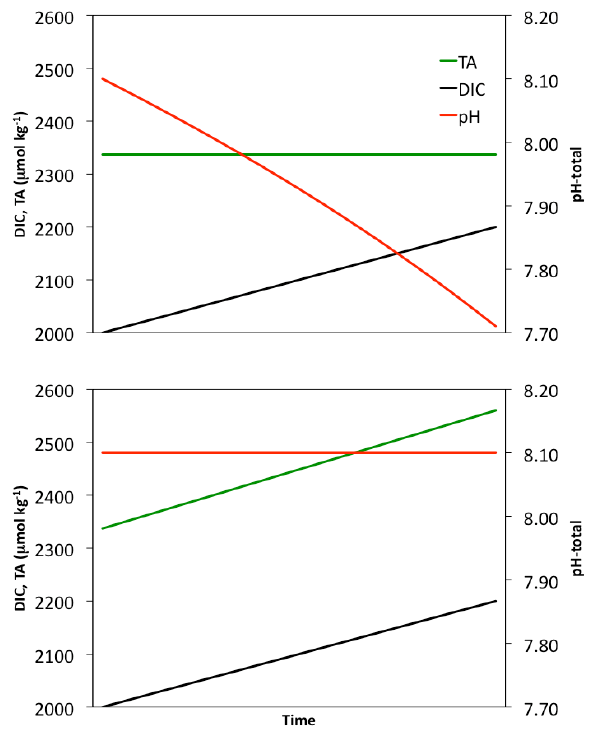
Fig. 3. Hypothetical illustration of a system that receives no buffer- ing (top panel) from dissolution of CaCO 3 minerals, i.e., seawater total alkalinity remains unchanged, and a system that is buffered by CaCO 3 dissolution (bottom panel) in order to maintain a con- stant pH, i.e., total alkalinity increases and accumulates within the